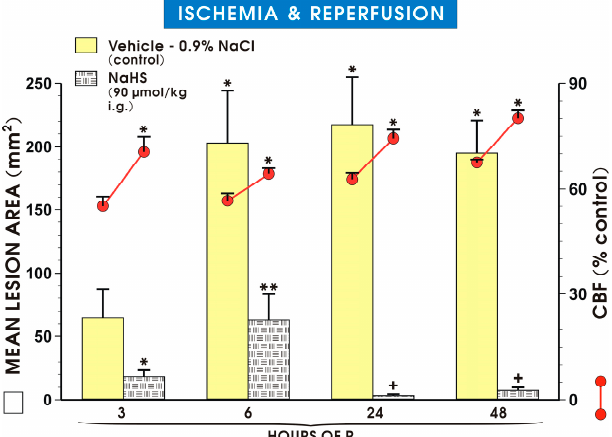
Figure 8. Mean lesion area and the GBF in gastric mucosa of rats pretreated with single dose of vehicle or NaHS (90 μ mol/kg i.g.) and exposed to 30 min of I followed by 3, 6, 24 and 48 h of R. Results are mean ± S.E.M. of 4–5 rats per each group. An asterisk indicates a significant change as compared with the value obtained in the vehicle-control group exposed to I and 3 h of R ( p < 0.05). Double asterisks denote a significant difference as compared with the values obtained in vehicle pretreated groups at respective times of R ( p < 0.05). Crosses indicate a significant difference as compared with the values obtained in NaHS-pretreated groups at 3 h and 6 h of R, respectively ( p < 0.05).